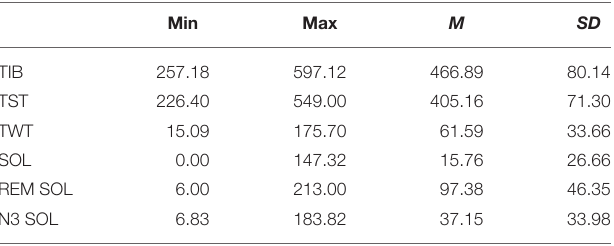
TABLE 2 | Overview of sleep stages (in percent) averaged over both nights ( n = 40). Min Max M SD Wake percentage 3.55 33.23 12.98 REM percentage 5.29 28.68 18.02 5.18 Non-REM percentage 45.39 87.78 N1 percentage 0.70 16.00 N3 percentage 16.72 Sleep Efficiency 66.77